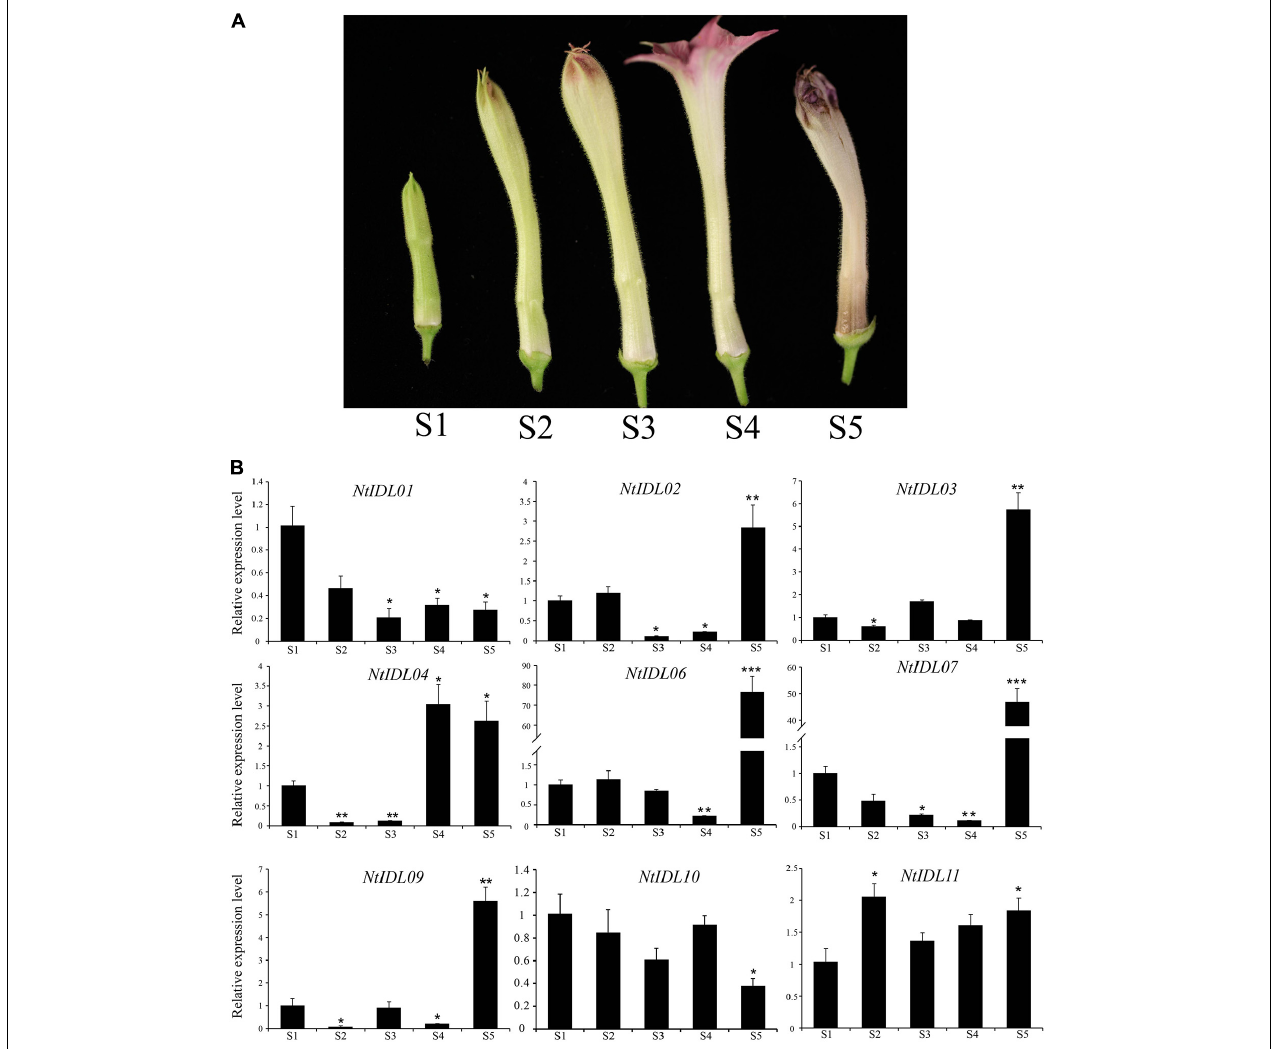
FIGURE 4 | The expression patterns of NtIDL genes in abscission zones during flower development. (A) . Five stages of tobacco flower development. “S1–S5” means “Stage 1 to Stage 5 of flower development” (B) . The expression patterns of selected NtIDL genes in the abscission zone during the flower development. All expression levels were calculated through the 2 − (cid:49)(cid:49) Ct method. The data were means ± SD from three independent replications. * p < 0.05, ** p < 0.01, and *** p < 0.001 ( t